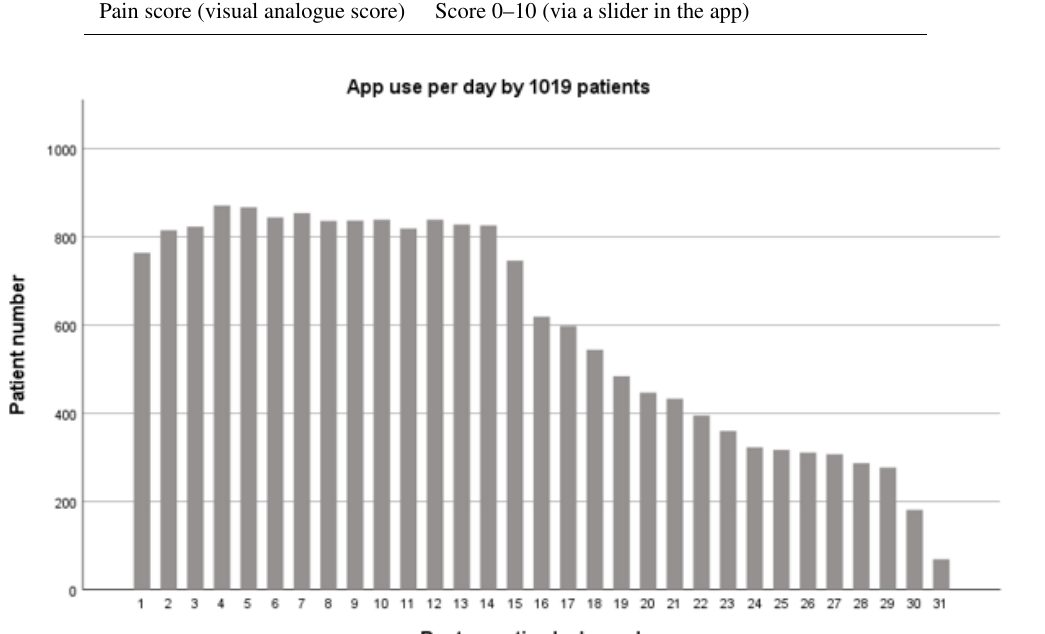
Figure 1. Daily wound care app use by patients during postoperative